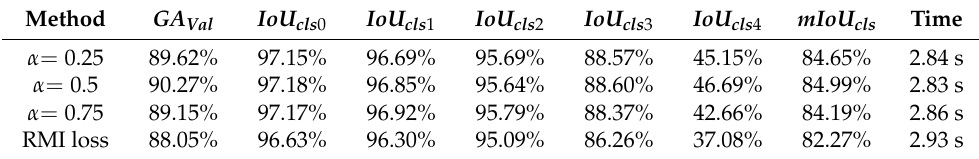
Table 4. The metrics results of Deeplabv3+–Mobilenetv2 under different conditions.